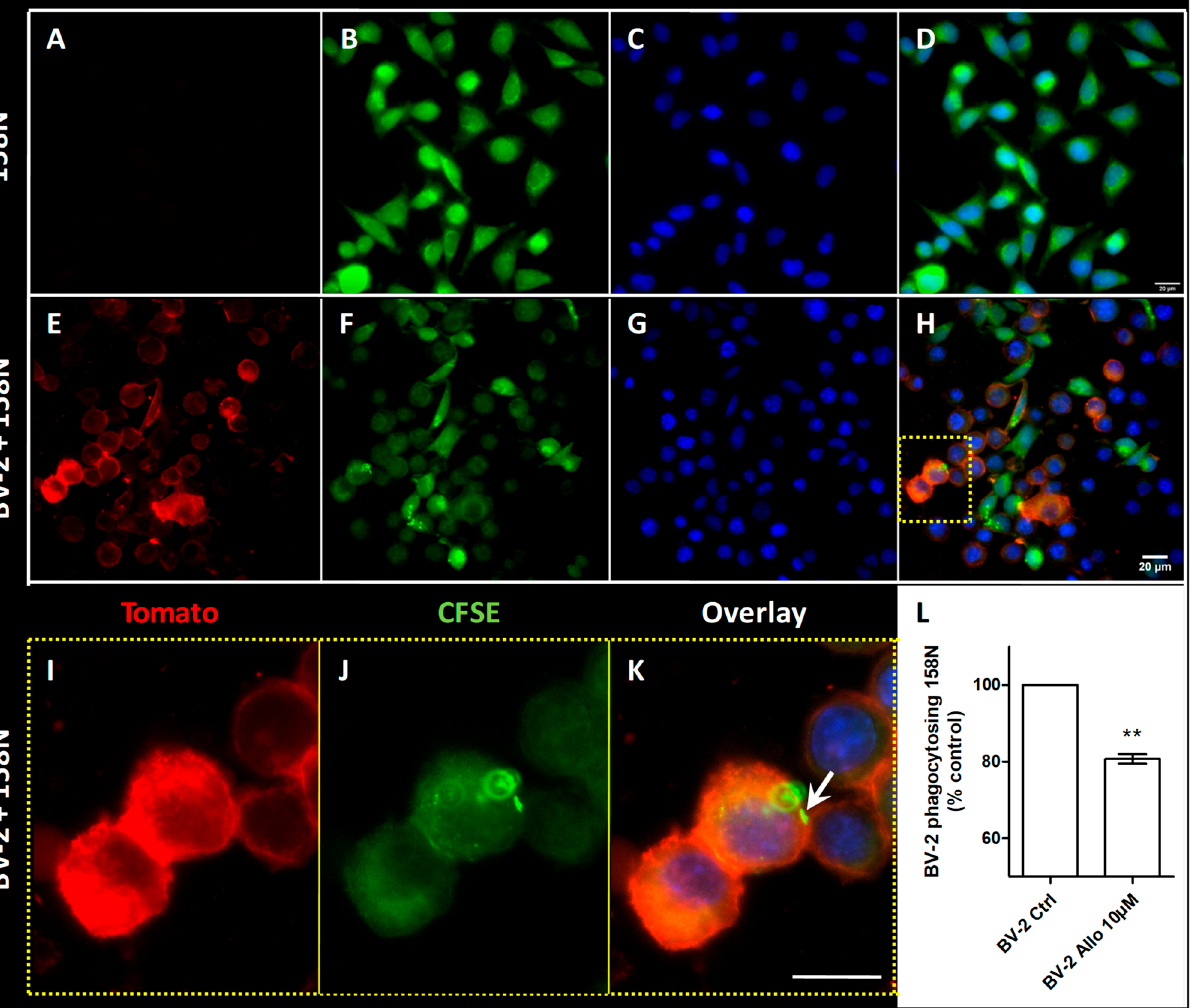
Figure 8. ALLO inhibits the inappropriate phagocytosis of oligodendroglial 158N cells by microglial BV-2 cells. ( A – K ) Microscopic observation of 158N cells either alone ( A – D ) or in coculture with BV-2 cells ( E – K ). BV-2 cells express the red fluorescent protein Tomato ( E , H , I , K ) and 158N cells are previously stained with the green fluorescent compound CFSE ( B , D , F , H , J , K ). The nuclei are observed by DAPI ( C , D , G , H , K ). The fluorescent signals detected in each channel are presented overlaid ( D , H , K ). The BV-2 cells observed in the yellow dashed box of the microphotograph ( H ) are shown with a higher magnification ( I – K ). One BV-2 cell contains green fluorescence derived from a phagocytized 158N cell (arrow). Scale bar = 20 µ m. ( L ) Flow cytometric measurement of red fluorescent BV-2 cells having phagocytized green fluorescent 158N. Mean values ± SEM are shown, from n = five independent experiments, ** p <